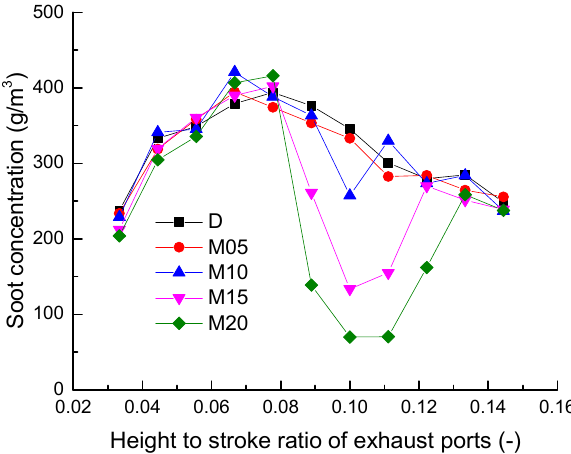
Figure 10. Soot concentration under different HSRs of exhaust ports.